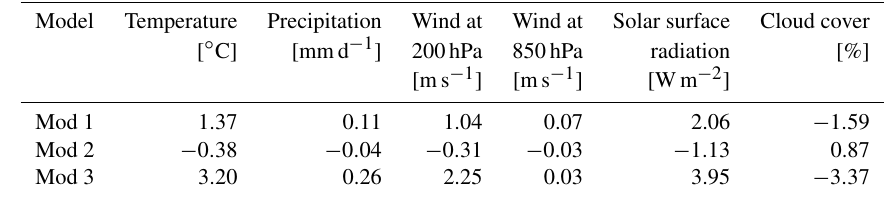
Table 2. Global mean average difference between the imperfect models and the perfect model, calculated over the last 30 years of the simulation.